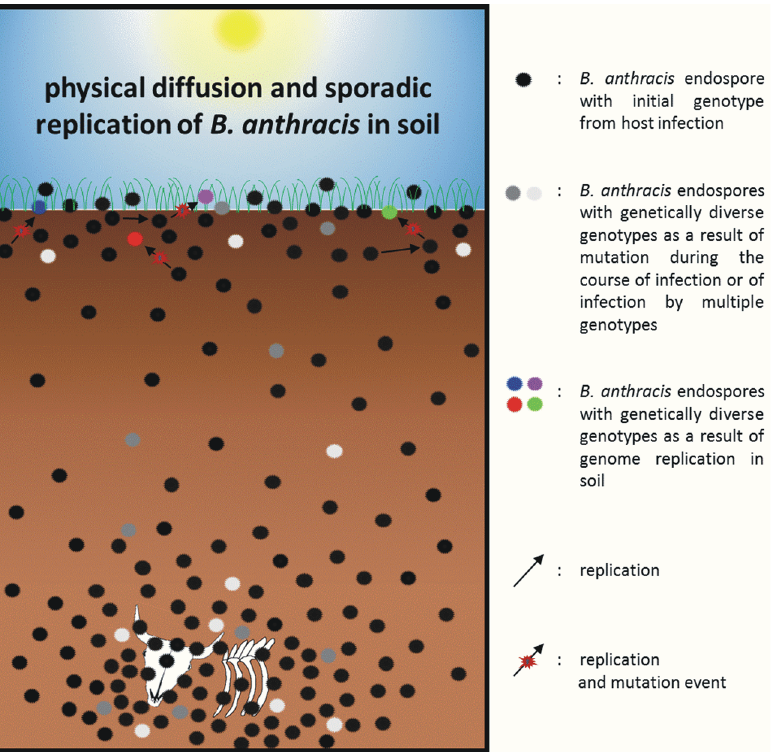
Fig 4. Modified (synthesis) model for B . anthracis genotype dynamics in soil of Pollino burial sites. Soil surrounding the carcass at the lower part of the figure harbors a very high endospore burden. Genetically diverse genotypes, which can be found near-carcass and near-surface, are the result of either multiple genotype infection or mutations during the course of host infection. Endospores reach the surface and accumulate via physical diffusion. Sporadic germination in soil or possibly in transient vectors, replication and sporulation under favorable conditions can lead to genetically diverse genotypes that can be found in near- surface